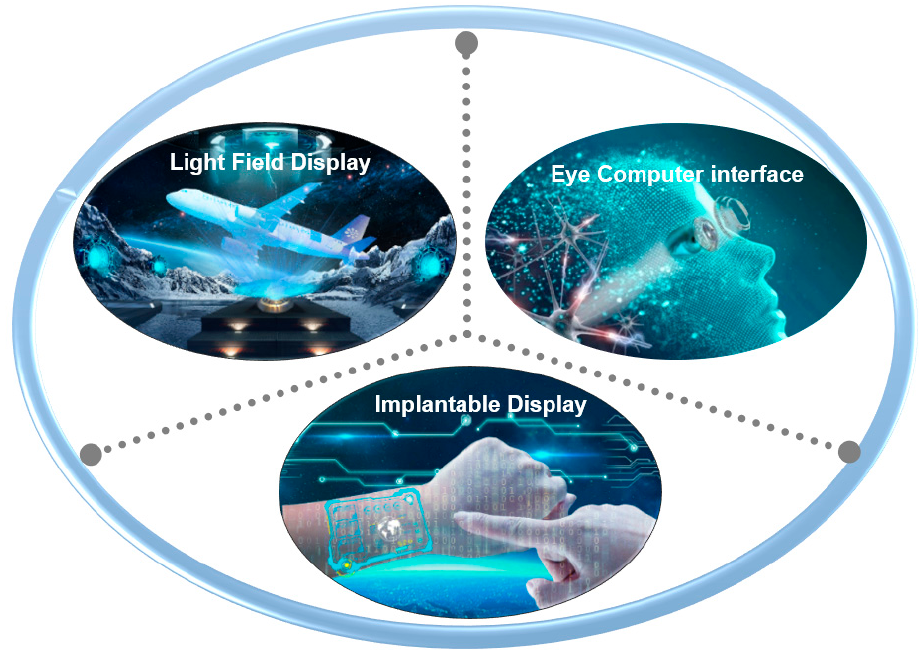
Figure 1. Potential applications of NLED.